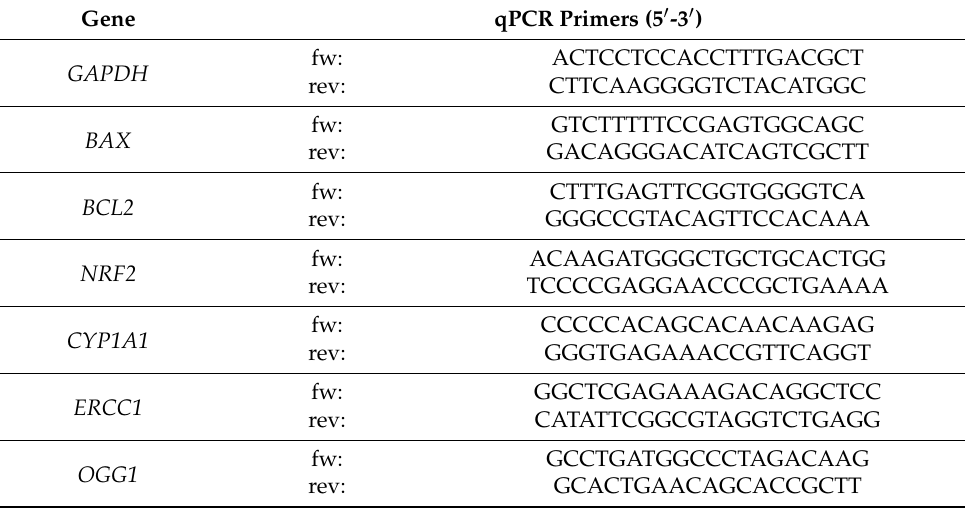
Table 1. Forward and reverse sequences of primers used in real-time PCR.